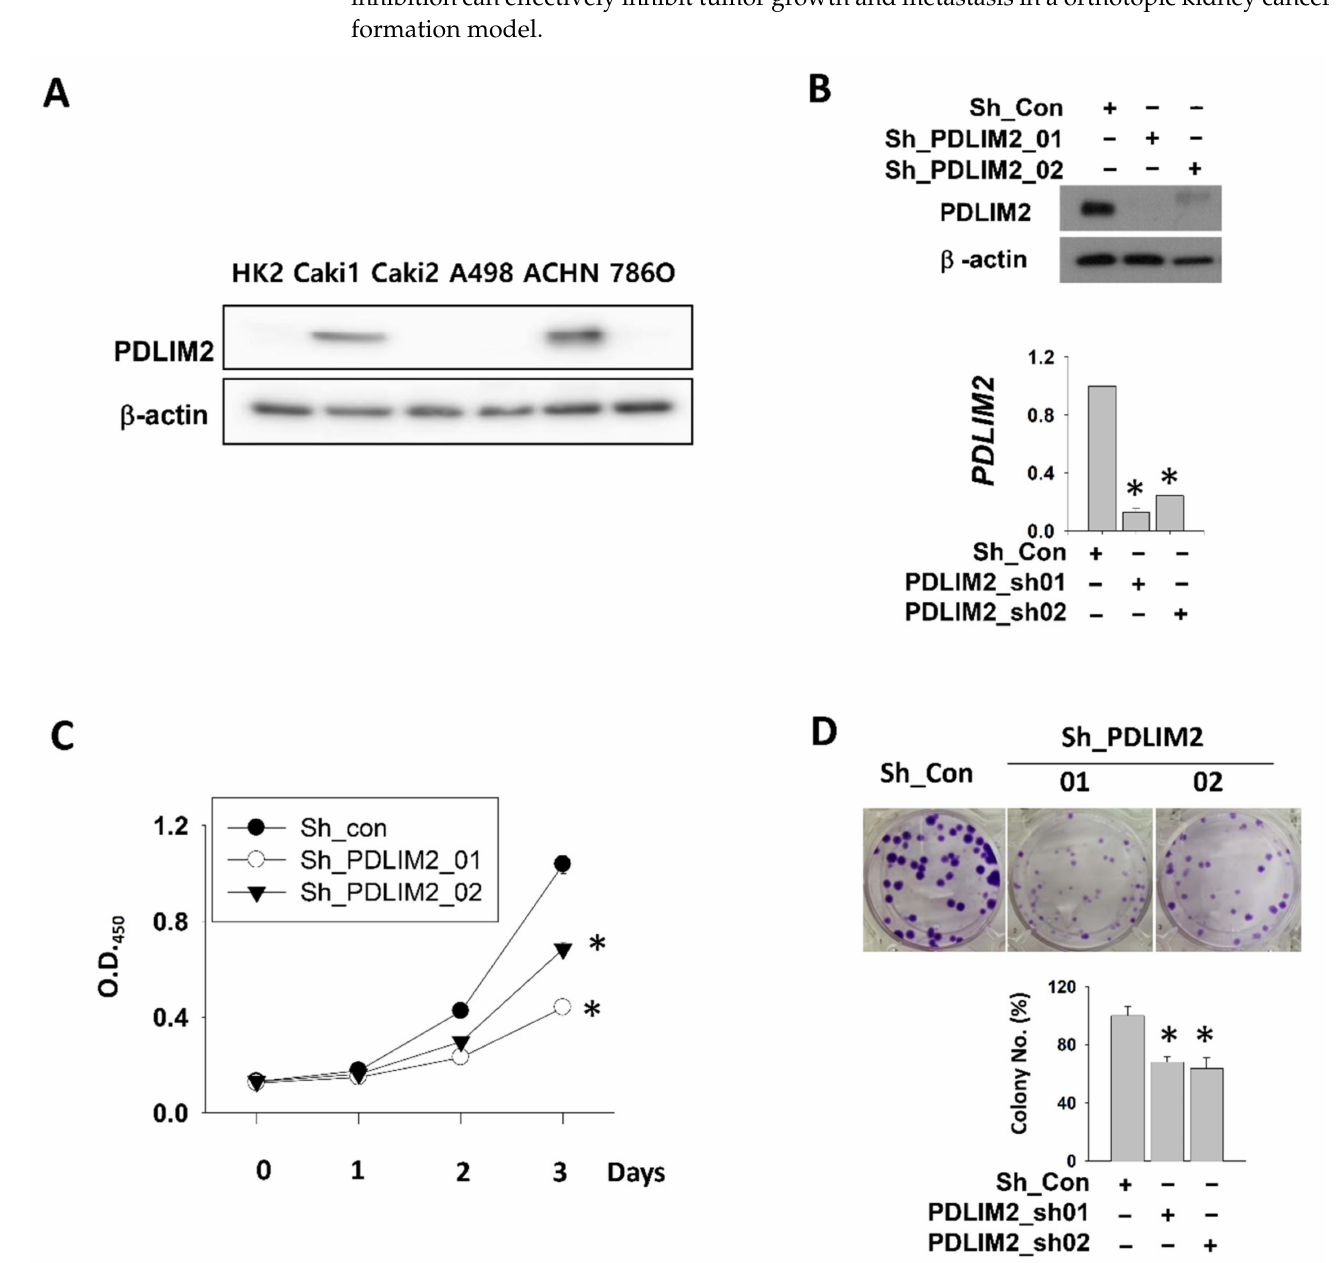
Figure 2. PDLIM2 inhibition attenuates metastatic kidney cancer cell proliferation. ( A ) PDLIM2 protein expression in various kidney cancer cell lines. Whole cell lysates were analyzed using the indicated antibodies. ( B ) The efficiency of PDLIM2 knockdown was measured by comparing the protein and mRNA levels of PDLIM2 in an shRNA-expressing Caki-1 cell line. Whole cell lysates were analyzed using the indicated antibodies (upper figure). Total RNAs from each cell line were measured using RT-qPCR (lower graph). ( C ) Time-dependent viability changes of control and PDLIM2 shRNA-expressing Caki-1 cells were assessed using EZ-Cytox solution. Bars represent the mean ± standard deviation (SD) of three independent experiments, and * denotes p < 0.05 (Student’s t -test) versus the control shRNA (Sh_con) group. ( D ) Crystal violet staining images of colonies formed by a similar number of shRNA-expressing Caki-1 cells. The average number of colonies counted is shown in the lower graph. Bars represent the mean ± SD of three independent experiments, and * denotes p < 0.05 (Student’s t -test) versus the control shRNA (Sh_con)